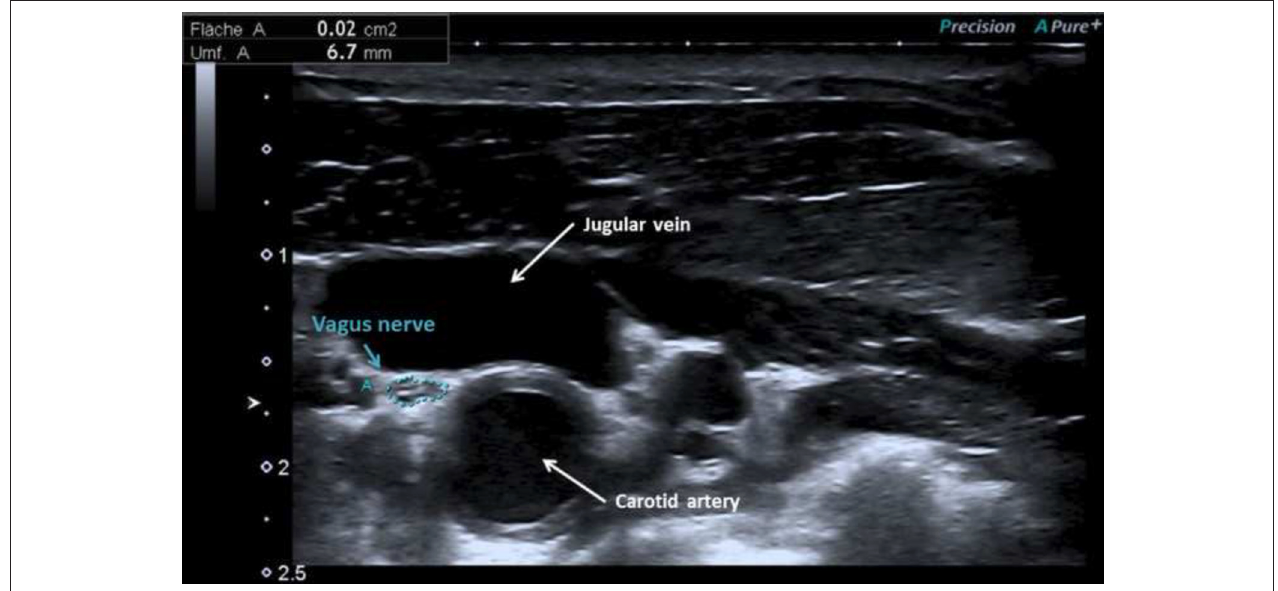
FIGURE 1 | Vagus nerve at the lateral margins of the anterior cervical region beneath the sternocleidomastoid in a patient with Parkinson’s disease with cross-sectional area of 2 mm 2 .